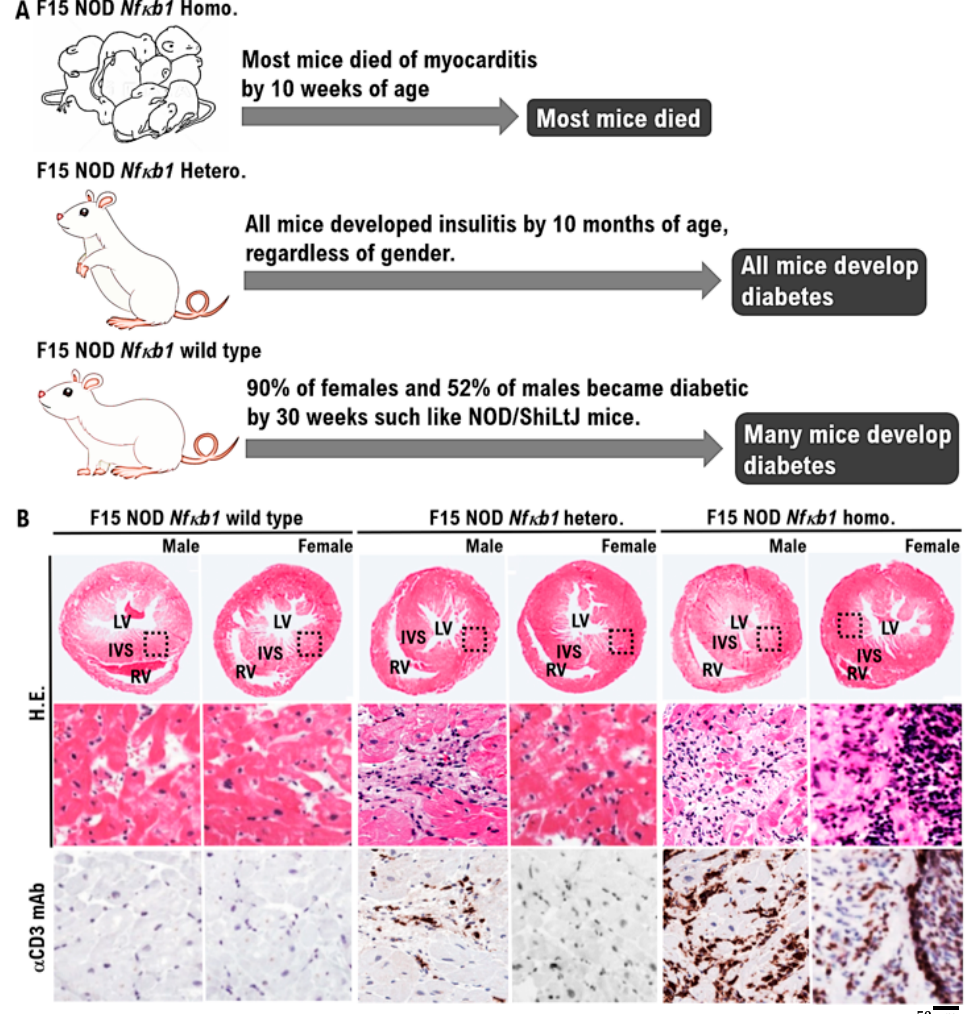
Figure 1. The onset of spontaneous myocarditis in F15 NOD Nf κ b1 homozygote mice. ( A ). The phenotype of F15 NOD mice is determined based on the expression status of the Nfkb1 gene. By 10 weeks of age, the majority of F15 NOD Nf κ b1 homozygote mice had died because of myocarditis. The incidence of spontaneous myocarditis was found to be slightly higher in male F15 NOD Nf κ b1 homozygote mice (incident rate: 95%, 19/20) than in female F15 NOD Nf κ b1 homozygote mice (incident rate: 75%, 15/20). By 10 months of age, all F15 NOD Nf κ b1 heterozygote mice developed insulitis, regardless of gender. In the case of F15 NOD Nf κ b1 wild-type mice, 90% of females and 52% of males developed diabetes by 30 weeks, similar to NOD/ShiLtJ mice. ( B ). Spontaneous myocarditis in F15 NOD Nf κ b1 heterozygote and homozygote male and female infant mice by 9 weeks of age. F15 hybrids of Nf κ b1 heterozygote (hetero.), homozygote (homo.), and wild-type mice with a nonobese diabetic/ShiLtJ background are shown. Histopathological examination revealed that both male and female infant mice died by 9 weeks of age because of myocarditis. Representative hematoxylin and eosin (H&E)-stained tissue sections and immunohistochemically stained tissue sections with anti-CD3 monoclonal antibodies of the hearts obtained from both male and female infant mice by age 4–8 weeks are shown. The immunohistology images show diffuse infiltration of CD3 positive T-cells, as indicated by anti-CD3 antibody staining (brown) in the lower panels. All subtypes of T cells always express the CD3 antigen on their surface. Images in upper panels x 40. Images in lower panels ×400. Experiments were conducted with 20 animals in each group. RV; right ventricle, LV; left ventricle, IVS; interventricular septum.